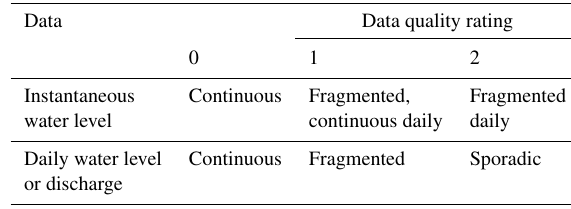
Table 3. The data quality rating for water level or discharge associ- ated with 12 of the 15 variables in the Canadian River Ice Database. Continuous indicates that there is no gap in the recorded hydromet- ric data, fragmented means that there are some gaps over the period of review and sporadic indicates that only limited data are available. This was a qualitative expert-judgement-based